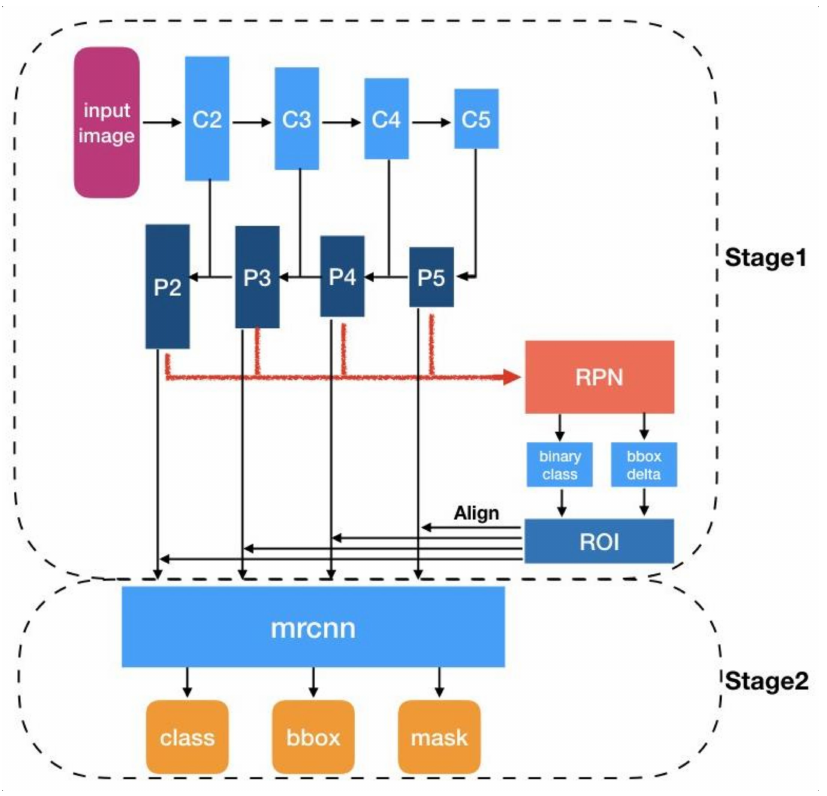
Figure 12. Summarised architecture of the Mask R-CNN Network.